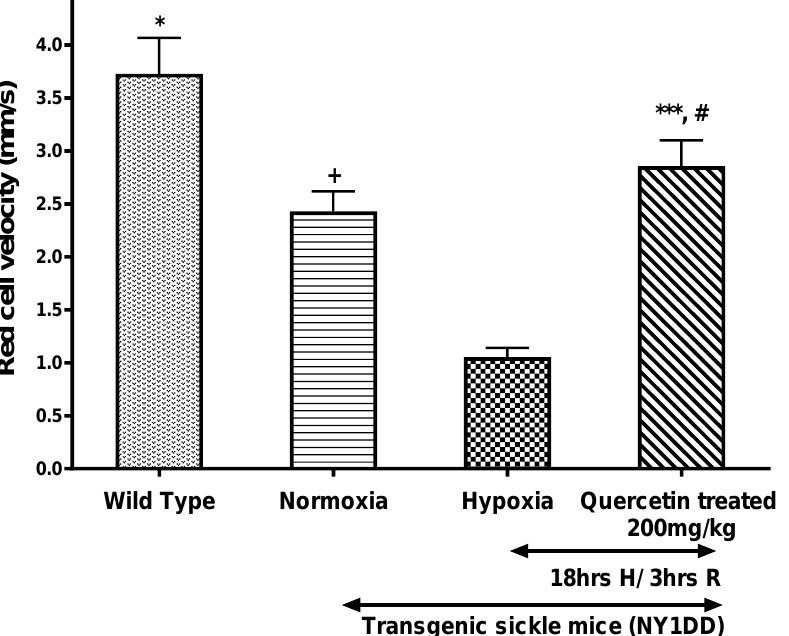
Figure 3. Effect of single dose of quercetin (200 mg/kg, i.p.) on red cell velocity (Vrbc) in wild type and NY1DD transgenic sickle mice under normoxia and hypoxia conditions. Values represent the mean ± SEM for four animals in each group; + p < 0.021 as compared to normoxic wild type controls; * p < 0.0001 as compared to H/R-induced NY1DD mice; # not significant as compared to normoxic NY1DD mice; *** p < 0.0001 as compared to NY1DD mice subjected to H/R (untreated).